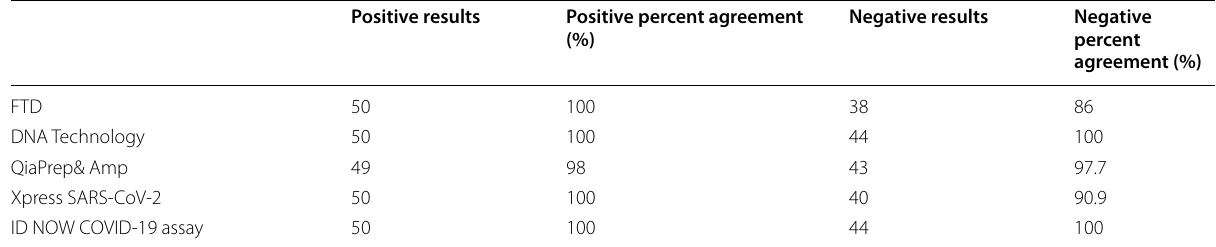
Table 2 Results of Positive percent agreement (PPA) and Negative percent agreement (NPA) of the five PCR kits compared to Viasure Positive